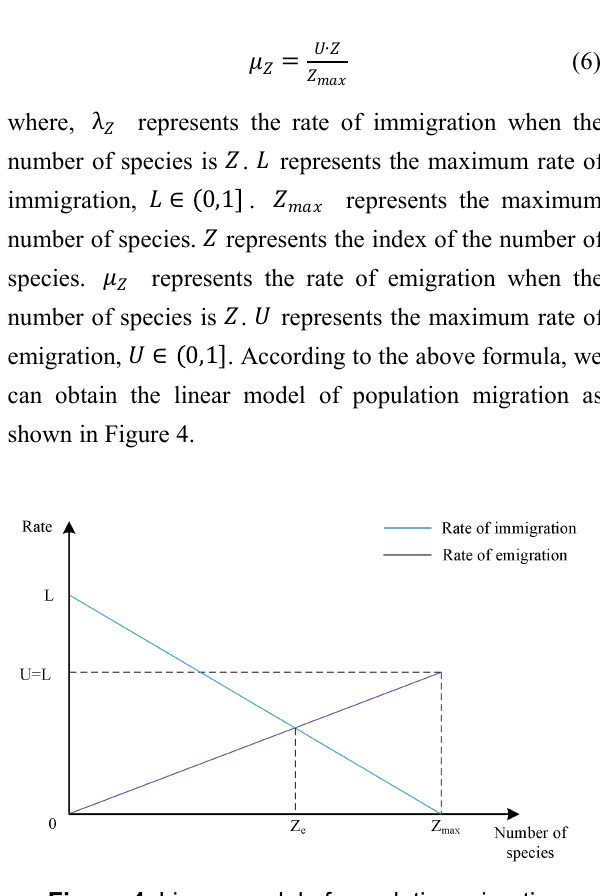
Figure 4. Linear model of population migration Mutation operation